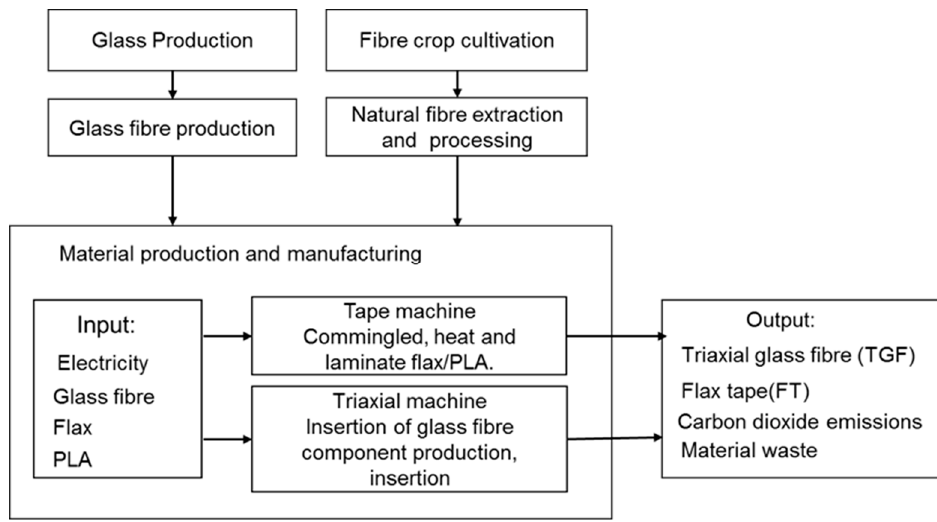
Figure 1. System boundaries of composites Flax / polylactic acid (PLA) tape manufacturing process and triaxial glass fibre (TGF) reinforced composites production process [38].